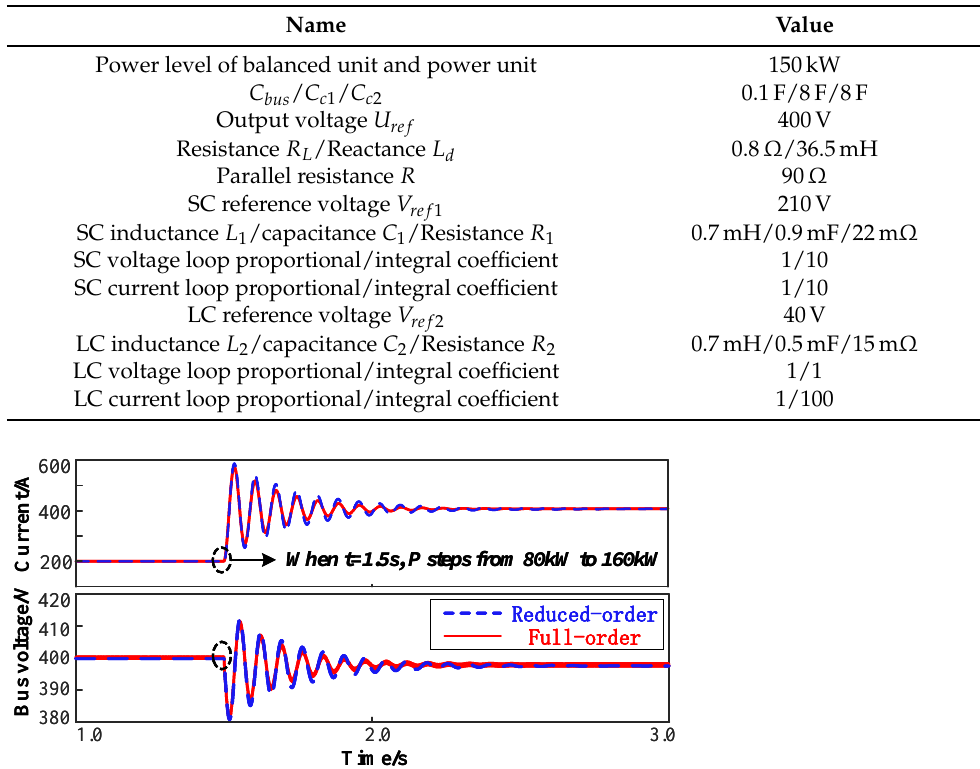
Table 2. Parameters of DC microgrid system.